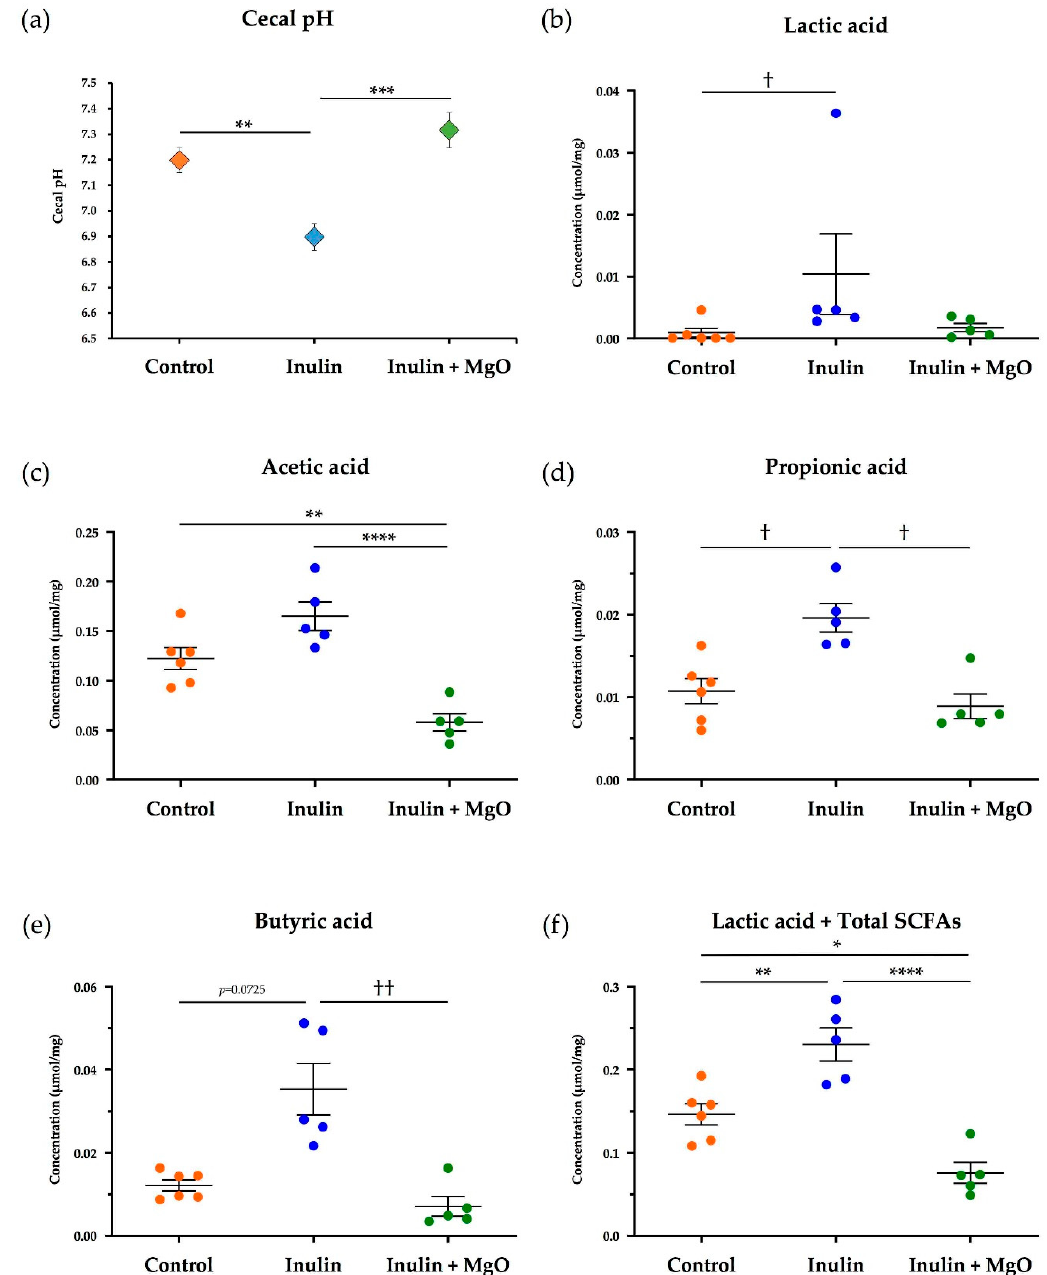
Figure 3. The combined inulin and MgO effects on cecal pH and SCFAs in mice on a HFD. ( a ) Cecal pH. ( b ) Lactic acid concentration of the cecal content. ( c ) Acetic acid concentration of the cecal content. ( d ) Propionic acid concentration of the cecal content. ( e ) Butyric acid concentration of the cecal content. ( f ) Lactic acid concentration + total SCFA concentration of the cecal contents (Total SCFA concentration is the total sum of the acetic acid concentration, propionic acid concentration, and butyric acid concentration). Inulin was mixed with the HFD at a ratio of 2.5% in the inulin group and the MgO combination group. Magnesium oxide was given in the diet at a ratio of 0.25%. Concentrations of lactic acid and each SCFA were calculated per dry weight of the cecal contents. All data are expressed as mean ± standard error (Each group n = 5–6). * p < 0.05, ** p < 0.01, *** p < 0.001, **** p < 0.0001, evaluated using the one-way ANOVA with Tukey’s post hoc test. † p < 0.05, †† p < 0.01, evaluated using the Kruskal-Wallis test with Dunn’s post hoc test. MgO: magnesium oxide. SCFA: short-chain fatty acid. HFD: high-fat diet.